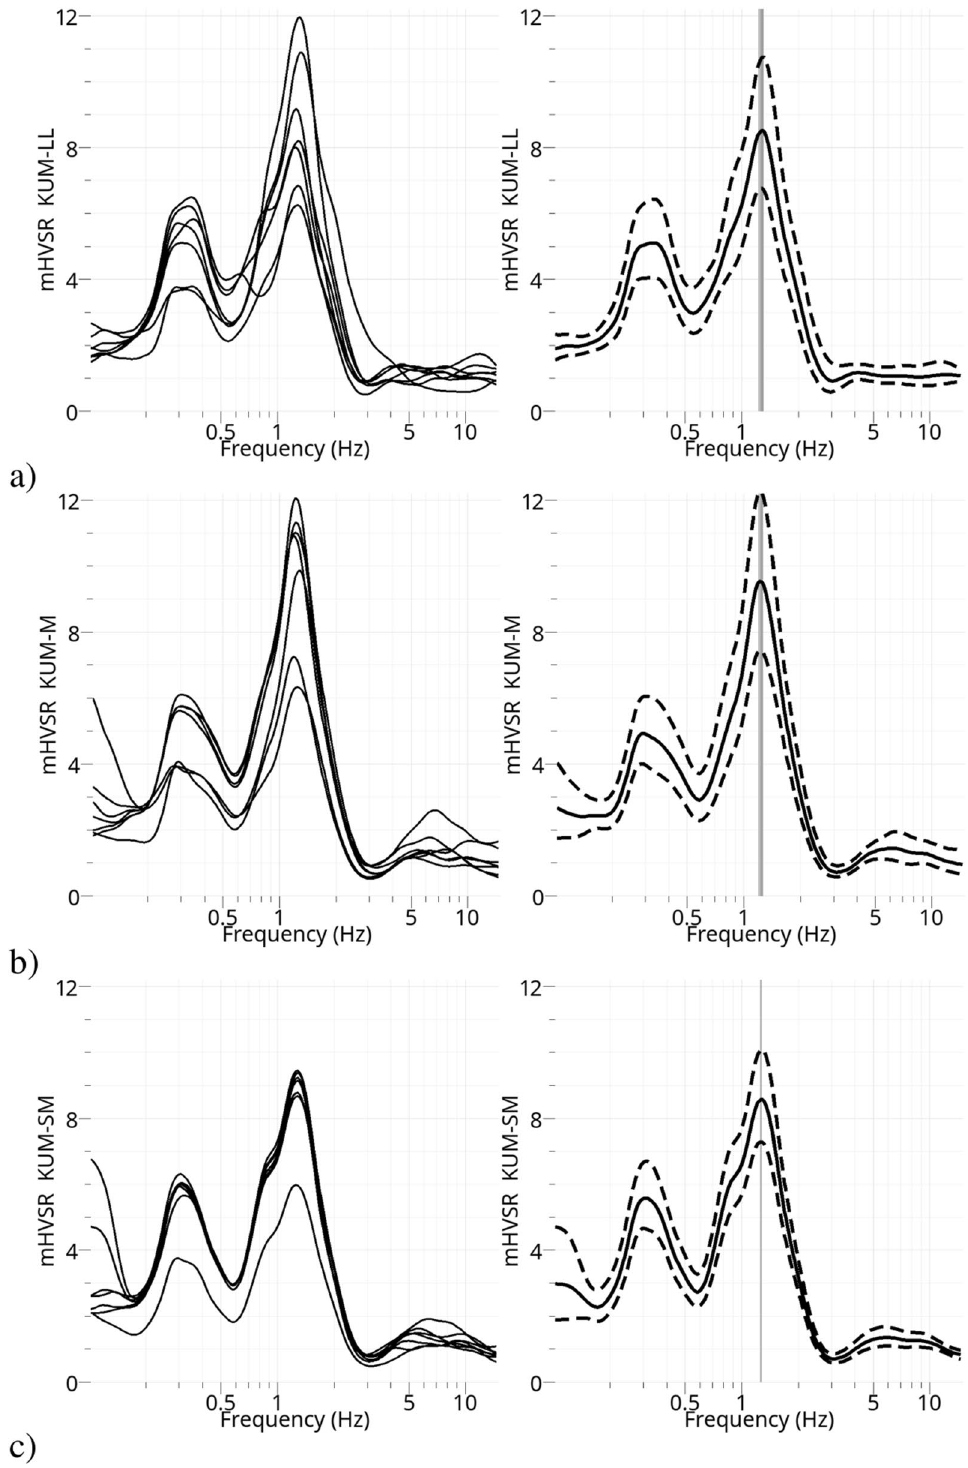
Fig. 10 Passive mHVSR; Mean mHVSR curves at each station of the arrays KUM-LL ( a ), KUM-M ( b ) and KUM-SM ( c ). Left column: individual curves; right column: mean of each array (solid line) and one standard deviation (dashed